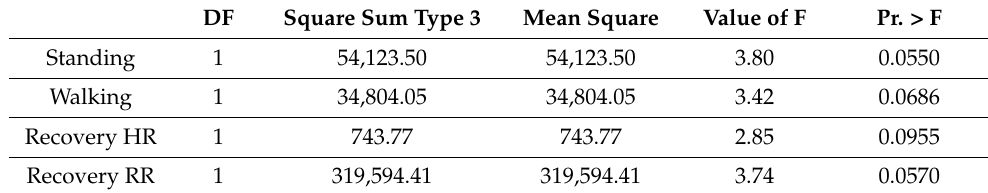
Table 9. The features found to be significantly affected by the sex factor ( p ≤ 0.1).